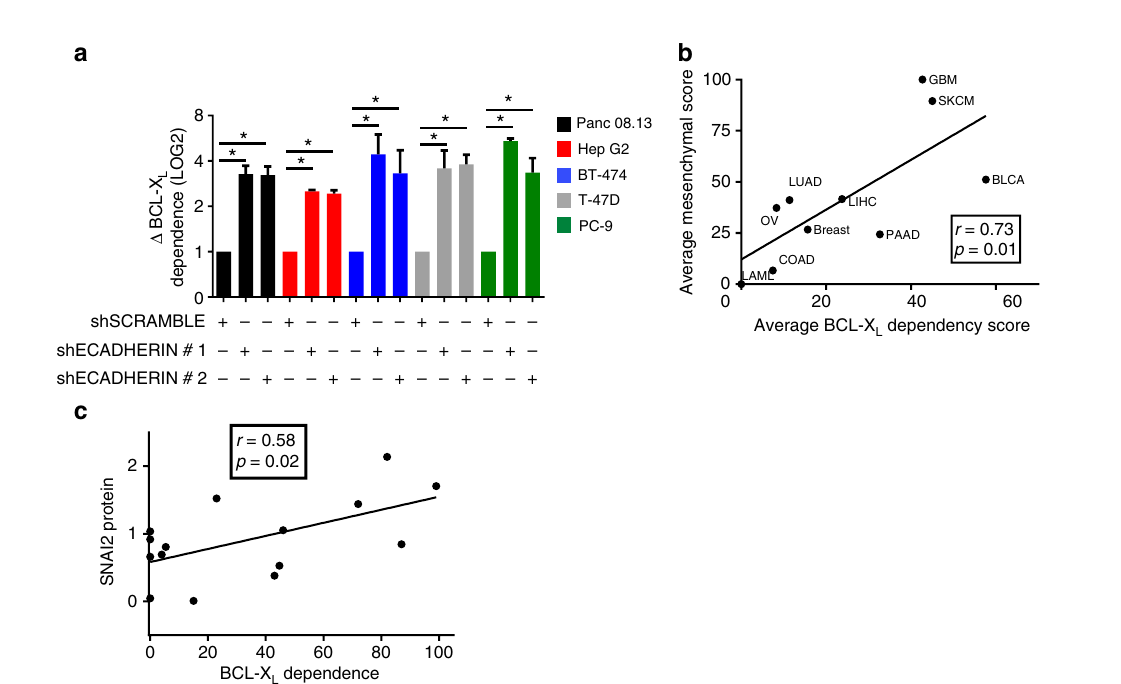
Fig. 4 Mesenchymal status predicts BCL-X L dependence. a , Changes in BCL-X L dependence score in cells that underwent an EMT. The 5 cell lines that exhibited a decrease in BCL-X L :MCL-1 synergy (Panc 08.13, Hep G2, BT-474, T-47D, PC-9) following EMT were treated with WEHI-539 for 3 days. Percentage viability loss was assessed via CTG and the change in BCL-X L dependence was calculated by normalizing the shECADHERIN transduced cells ( n = 3) to the shSCRAMBLE ( n = 3) and data are presented as the mean change (LOG2) in BCL-X L dependence ± SEM. A student's t -test was performed between each shECADHERIN vs shSCRAMBLE (* = p < 0.05). b The tissue-average mesenchymal and BCL-X L dependence scores were compared via Pearson correlation analysis. c The cell line protein expression (see Supplementary Fig. 5) of SNAI2 (SLUG), one of the genes from the mesenchymal signature, was correlated to BCL-X L dependence or BCL-X L :MCL-1 synergy via a Pearson correlation